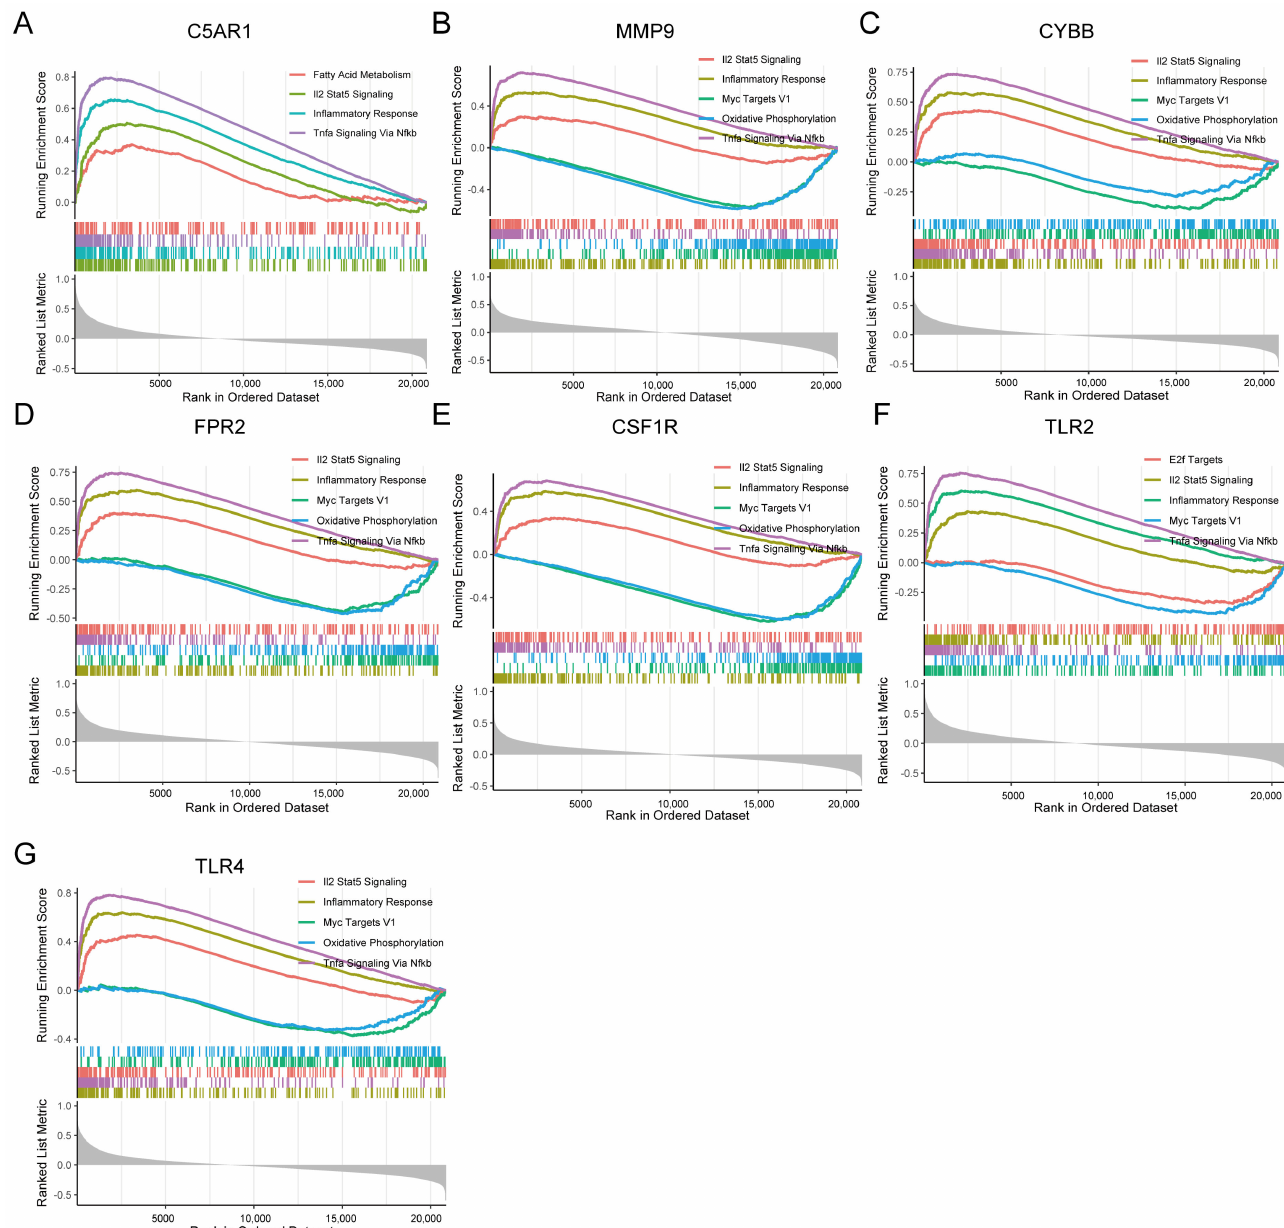
Figure 7. Gene set enrichment analysis reveals pathways of the seven-hub immune-related genes involved in CVD. ( A ) C5AR1; ( B ) MMP9; ( C ) CYBB; ( D ) FPR2; ( E ) CSF1R; ( F ) TLR2; ( G )